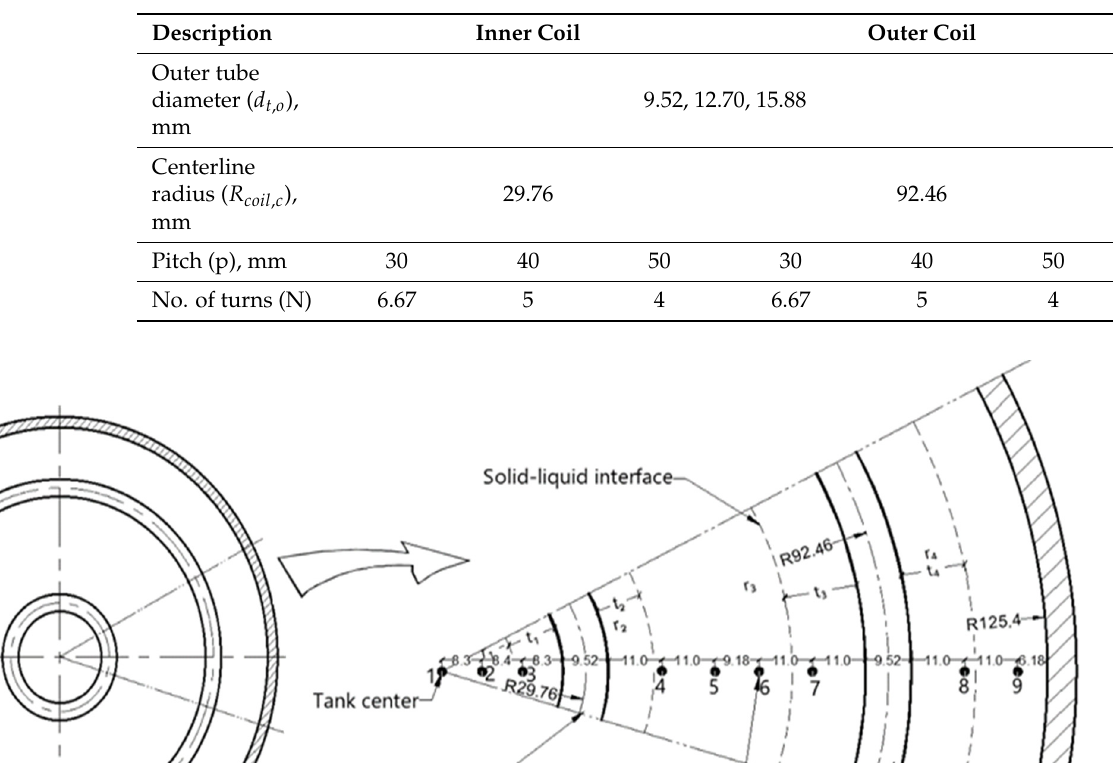
Table 3. Geometrical parameters of the twin-centric helical coils.